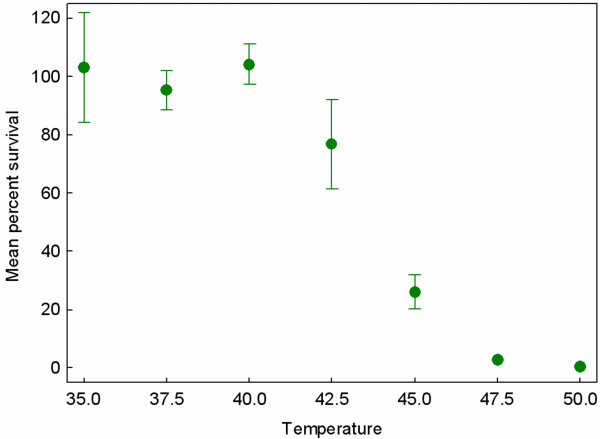
Percent survival across a thermal gradient for wild type virus φ6 reveals that elevated temperatures are harmful for virus survival. Each point is the mean of 3 to 5 measures, and error bars are 95% confidence intervals.